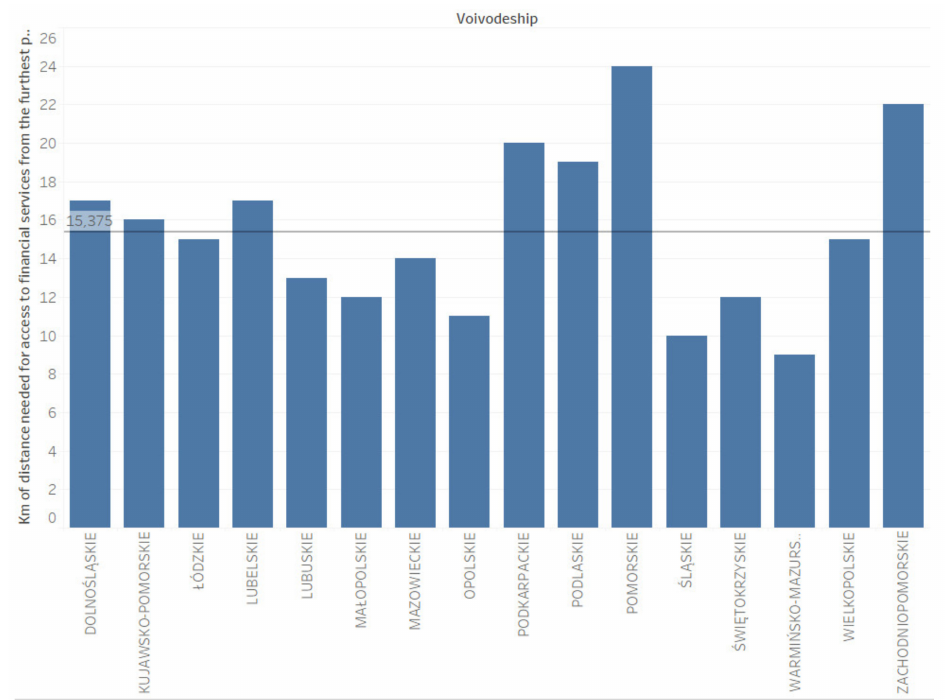
Figure 6. Kilometers of distance needed for access to financial services from the furthest point in Za- chodniopomorskie, Wielkopolskie, Warmi´nsko-Mazurskie, ´Swi˛etokrzyskie, ´Sl ˛askie, Pomorskie, Pod- laskie, Podkarpackie, Opolskie, Mazowieckie, Małopolskie, Lubuskie, Lubelskie, Ł ó dzkie,